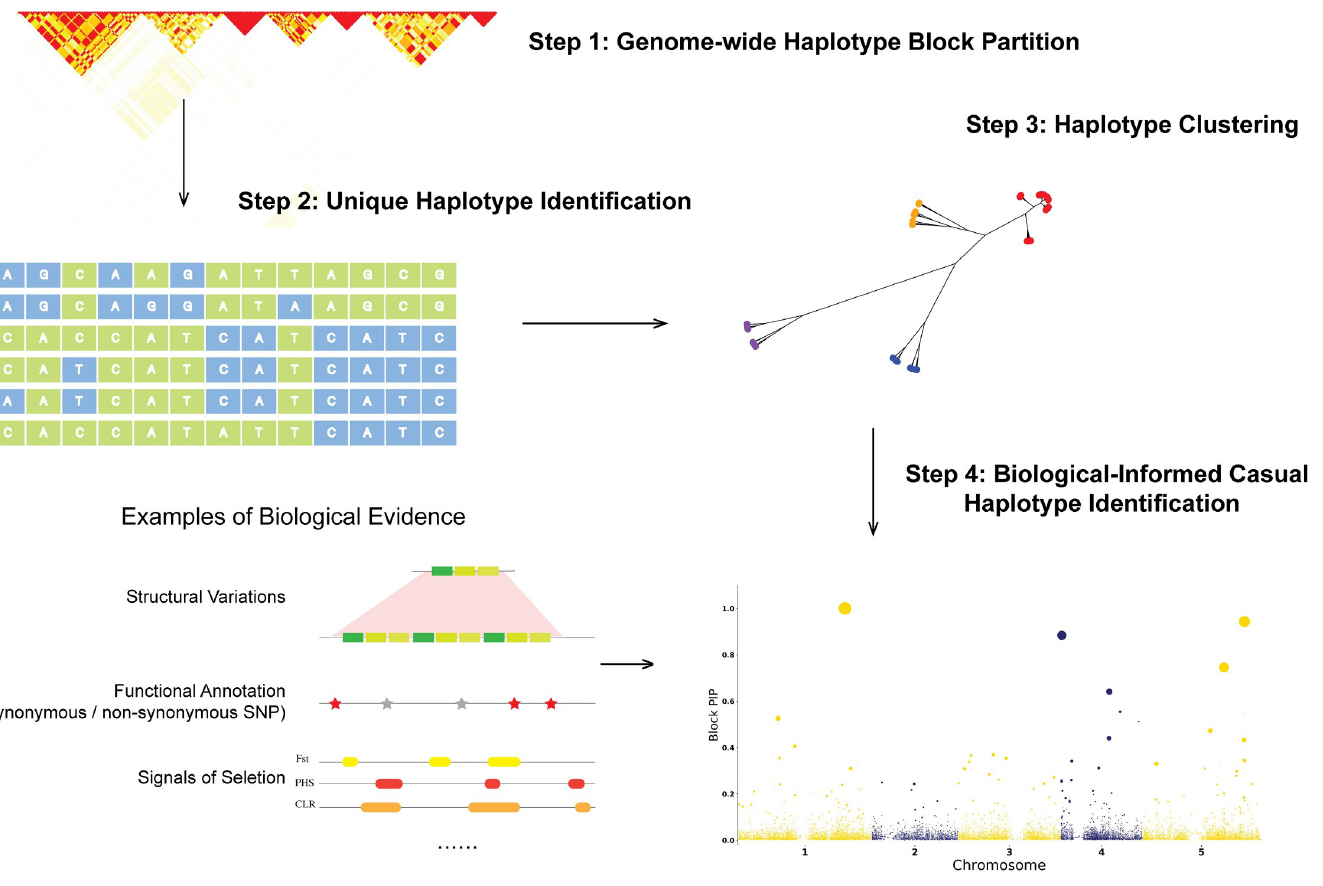
Fig 1. The workflow of haplotype-based trait fine mapping (HapFM). HapFM consists of four steps: genome-wide haplotype block partition, unique haplotype identification, haplotype clustering, and causal haplotype identification. Biological features, such as structural variations, functional annotations, signals of selection, etc. can be incorporated into the fine mapping model. The y -axis of Manhattan plot generated by HapFM is block pip, indicating causal probability. The size of the dot indicates the effect size of the block.